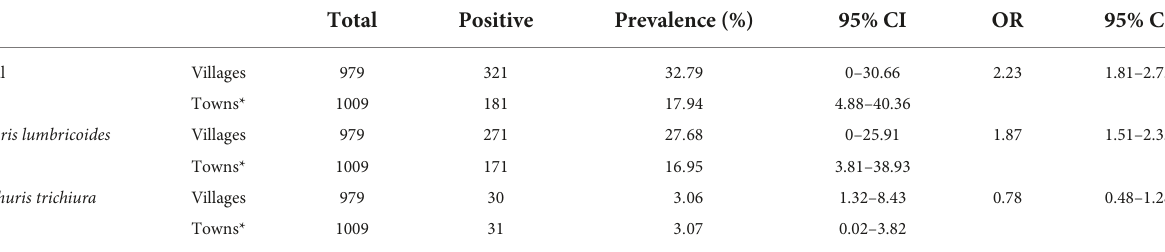
TABLE 2A Soil-transmitted helminths (STH) prevalence in the Roma population of Eastern Slovakia (Košice and Prešov regions) categorized by residency